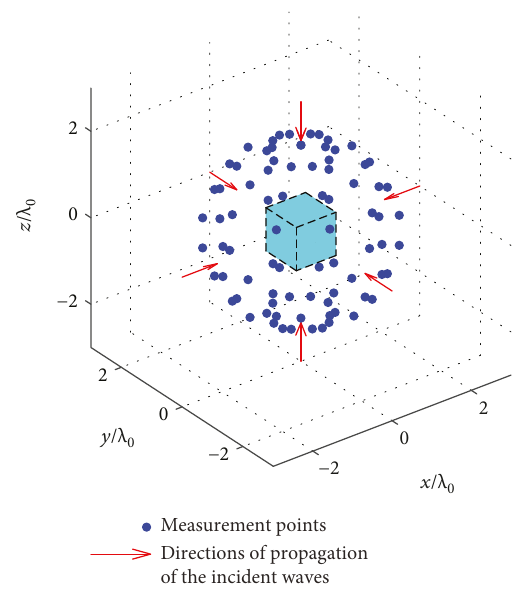
Figure 3: Measurement and illumination setup for the numerical validation of the proposed 3D full-vector microwave imaging